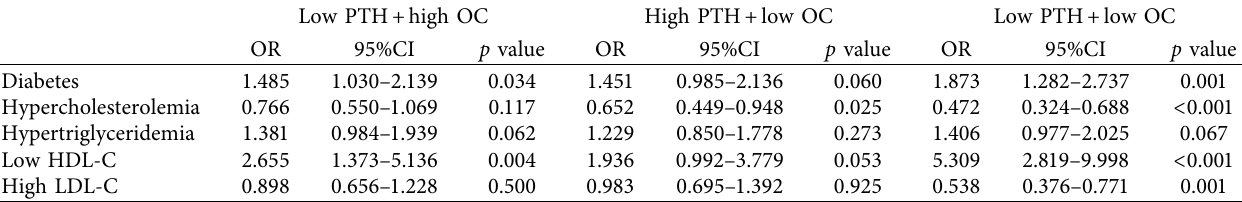
Table 4: Odds and 95% CI for diabetes and dyslipidemia between subgroups classified by the median levels of PTH and